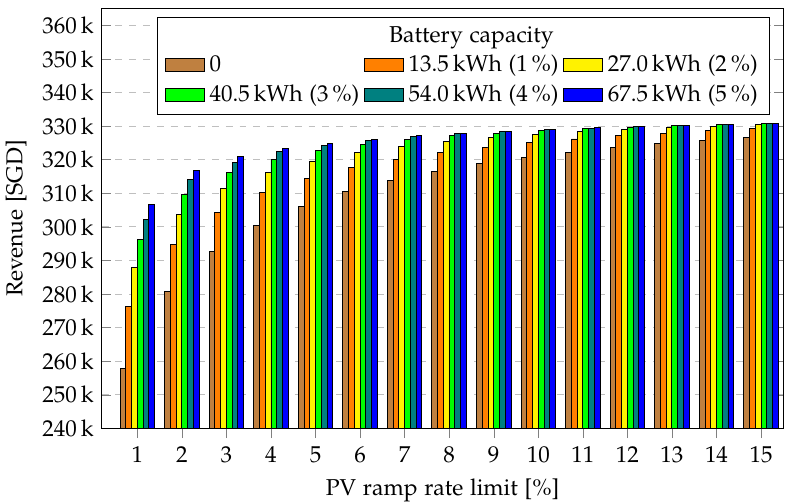
Figure 7. Revenue from PV to grid over PV ramp rate limit for various battery capacities for one year. In Figure 8, the PV ramp cost for the entire year is presented for a 13.5-kWh battery for various battery ramp limits over the PV ramp rate limit. When the battery ramp limit is increased from 10% to 20%, a significant drop in PV ramp cost is achieved. Beyond 40%, however, no significant benefit is achieved; rather, it could be detrimental to the battery due to degradation. A similar depiction is observed in Figure 9, with increasing energy-to-grid revenue for increasing battery ramp limit. Beyond a certain battery ramp limit, the marginal increase in revenue may not offset the cost of battery degradation.